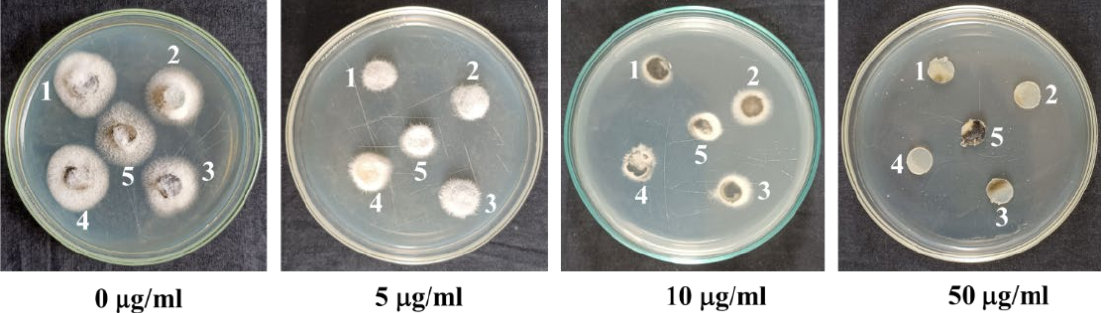
Figure 7. Sensitivity of different strains ( 1 – 5 ) of wheat blast fungus Mahnaporthe oryzae Triticum obtained from the field-infected spikes to various doses of a commercial fungicide Nativo. 1 , BTKP 22(3) collected in 2022; 2 , BTJP 194-2 collected in 2019; 3 , BTJP 1910-3 collected in 2019; 4 , BTJP 2 g collected in 2017; and 5 , BTJP 4 (5) collected in 2016. The PDA plates were cultured at 25 °C for 3